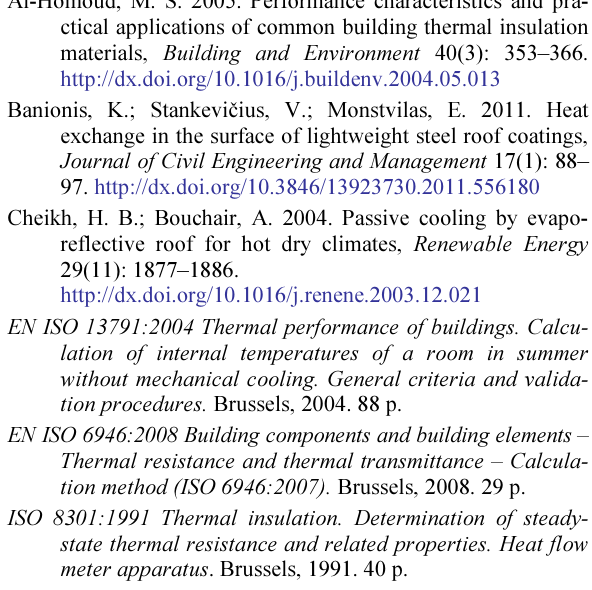
Table 3. Measured and calculated average daily heat flow rate through the cell roof constructions Experimental stage Experiment No. 1 Experiment No. 2 Experiment No. 3 Experiment No. 4